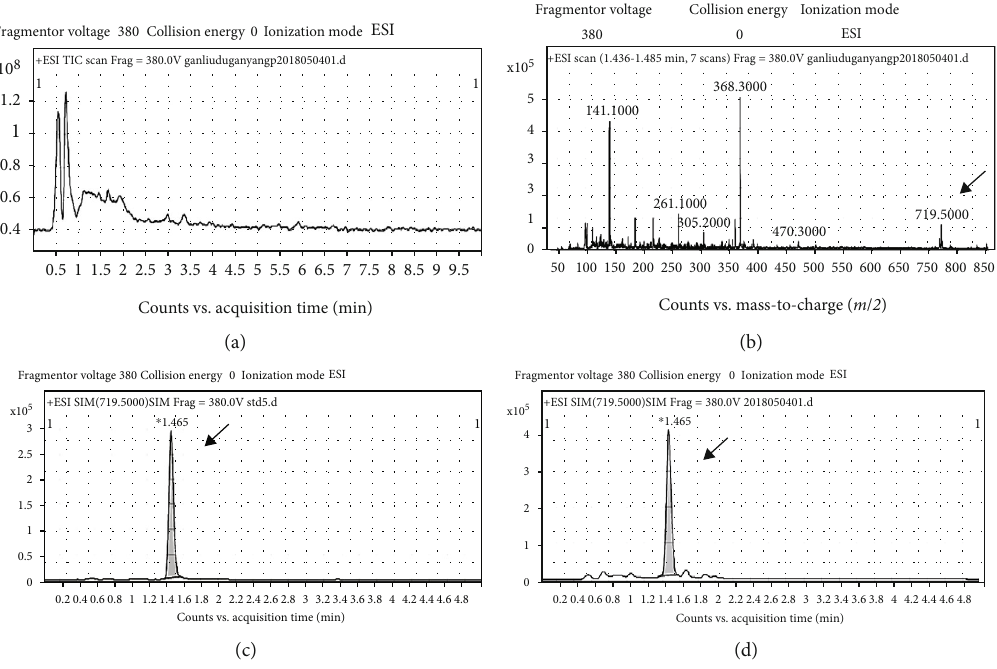
Figure 1: Determination of periplocin in PFS: (a) TIC of PFS; (b) TIC showing the peak of periplocin in PFS; (c) typical XIC showing the peak of periplocin standard; (d) typical XIC showing the peak of periplocin in